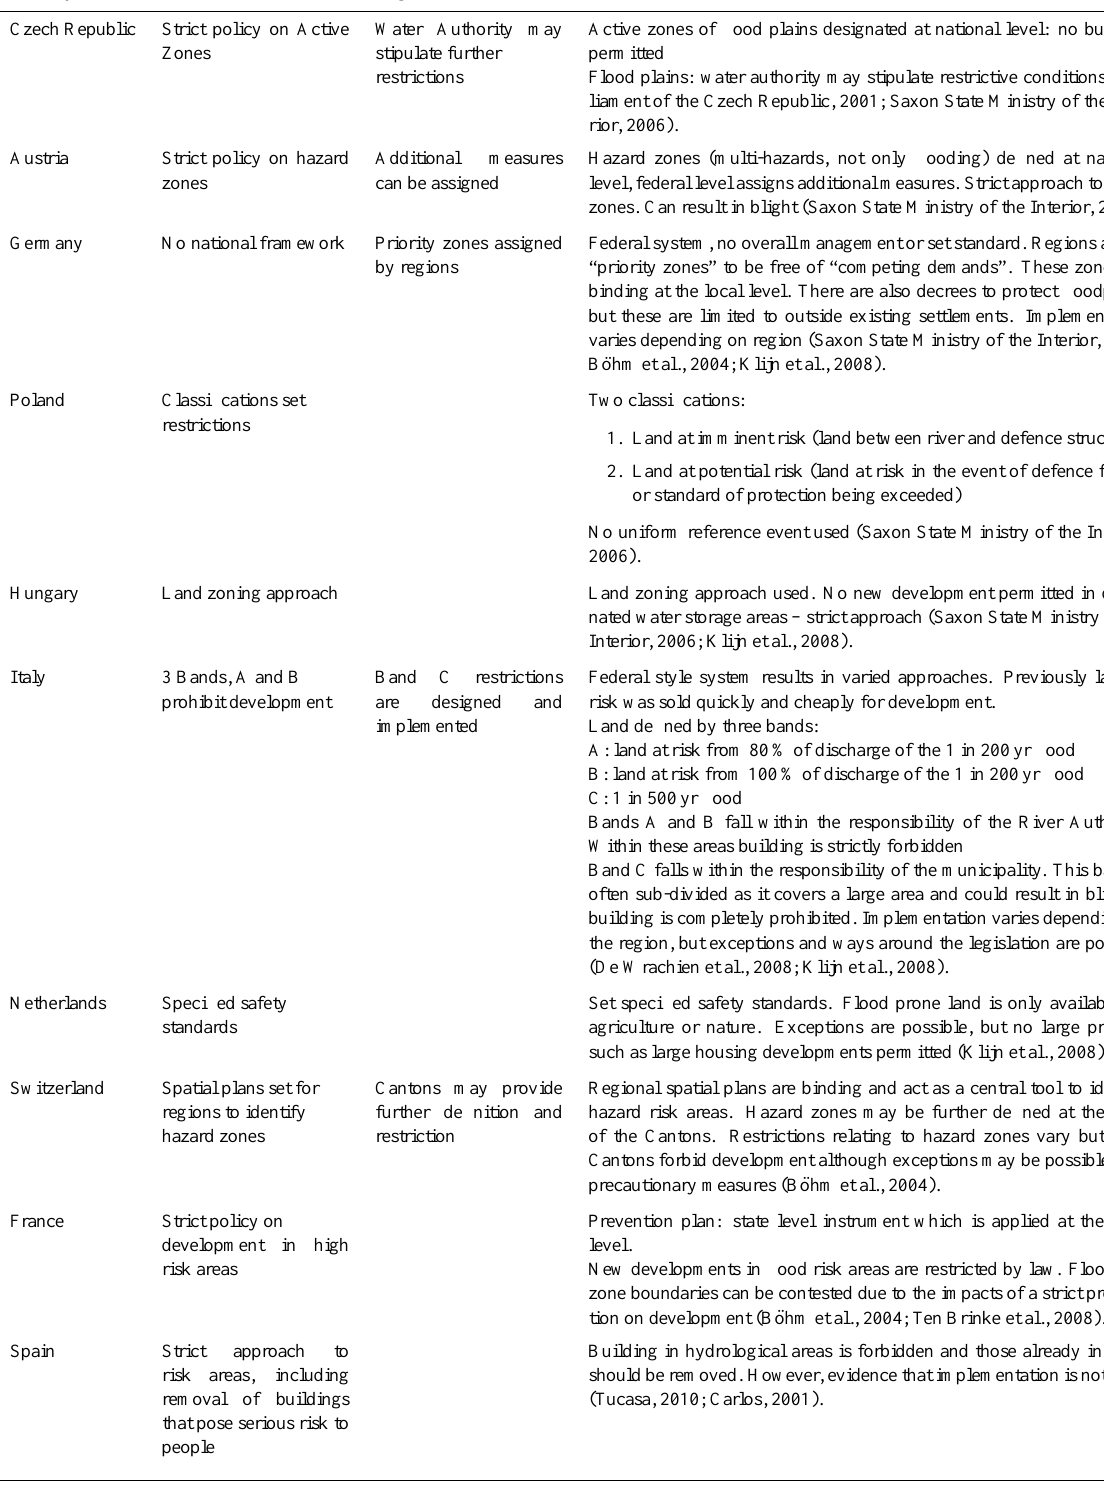
Table 3. Examples of spatial planning policy in other European countries.